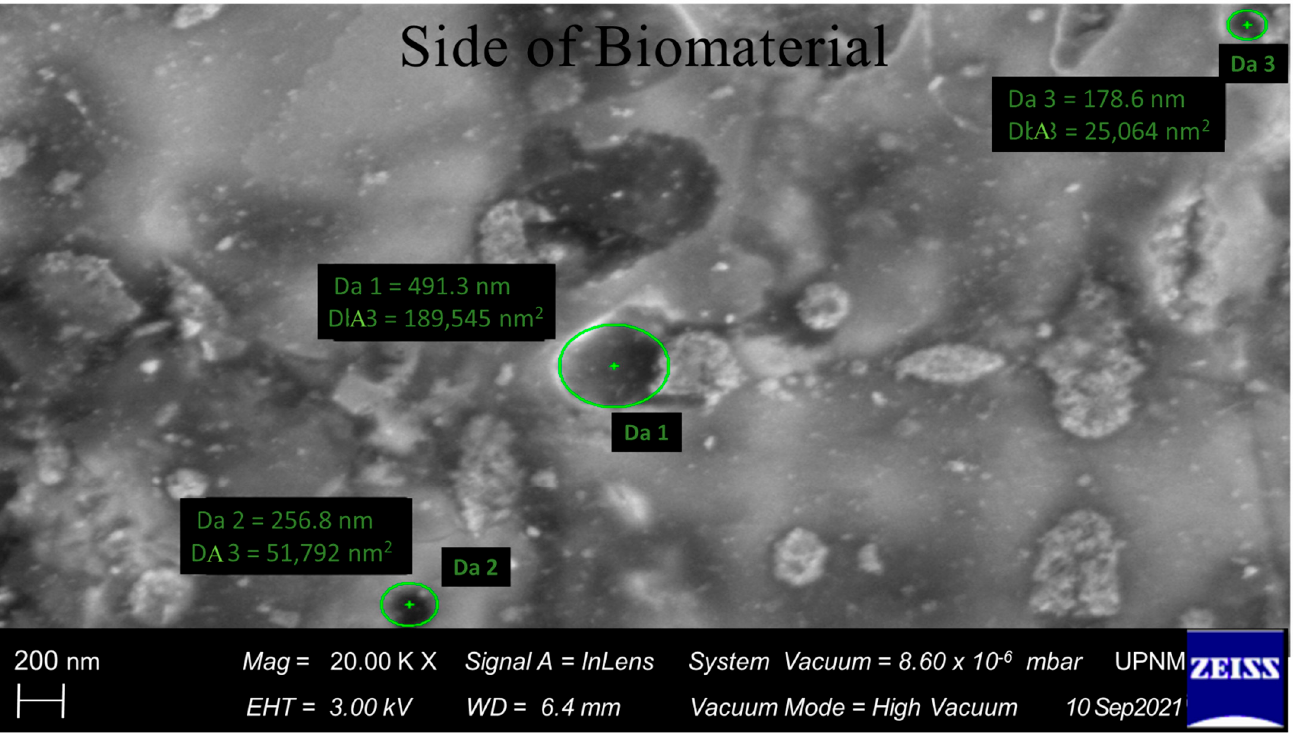
Figure 4. Pore diameters and areas in the side view of biomaterial at 20,000 times magnification. Table 1. Summary of diameter and area on the surface, side and cross-section of biomaterial from various